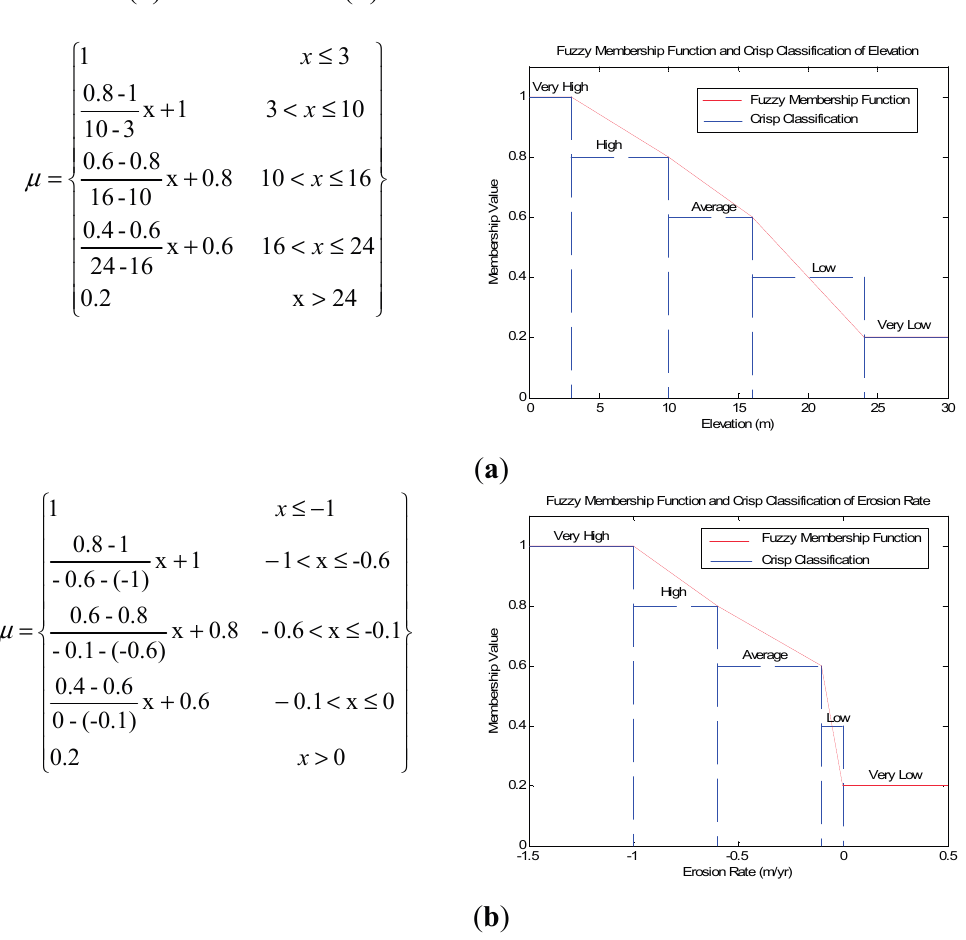
Figure 5. A graphical example of membership functions of some indicators and their crisp classifications: ( a ) Elevation and ( b ) Erosion